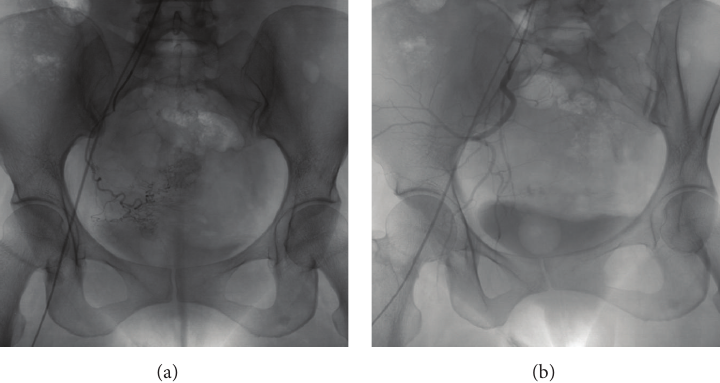
Figure 12: Conventional angiogram (a) in a 23-year-old nulliparous woman with GTN and recurrent massive intraperitoneal bleed showing a uterine vascular malformation on the right side. Selective right uterine artery catheterization was performed via right common iliac artery approach followed by embolization with polyvinyl alcohol gel foam. Postembolization angiogram (b) demonstrates complete obliteration of the vascular